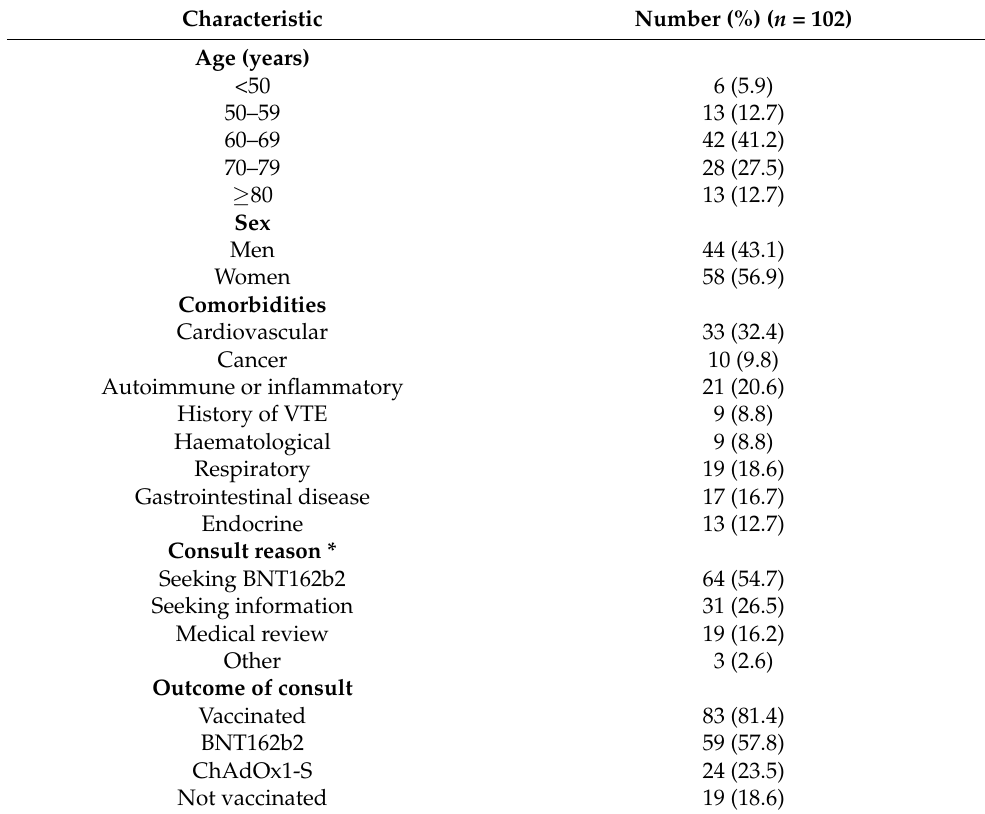
Table 1. Baseline characteristics of study population receiving medical consultation for COVID-19